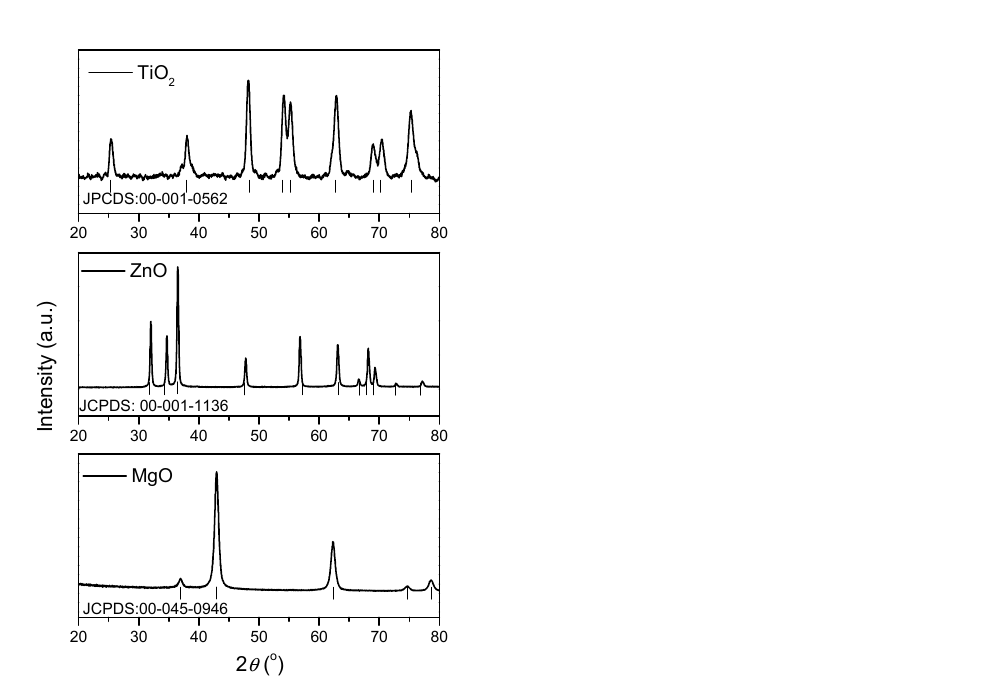
Figure 1. XRD patterns for TiO 2 , ZnO and MgO synthesized through the sol–gel method. Thus, it can be seen that the sample TiO 2 showed characteristic peaks of anatase as an only phase, with lattice parameters a = b = 3.7300 Å and c = 9.3700 Å, space group I 4/ amd according to JCPDS card no. 00-001-0562. In the case of ZnO, this crystallized in typical hexagonal phase with wurtzite structure, space group P 63 mc and lattice parameters: a = b = 3.25229 Å and c = 5.2096 Å according to JCPDS card no. 00-001-1136. The XRD pattern of the MgO sample indicated a unique phase without any other crystalline im- purities detected. The diffraction peaks corresponded to the cubic crystalline phase with